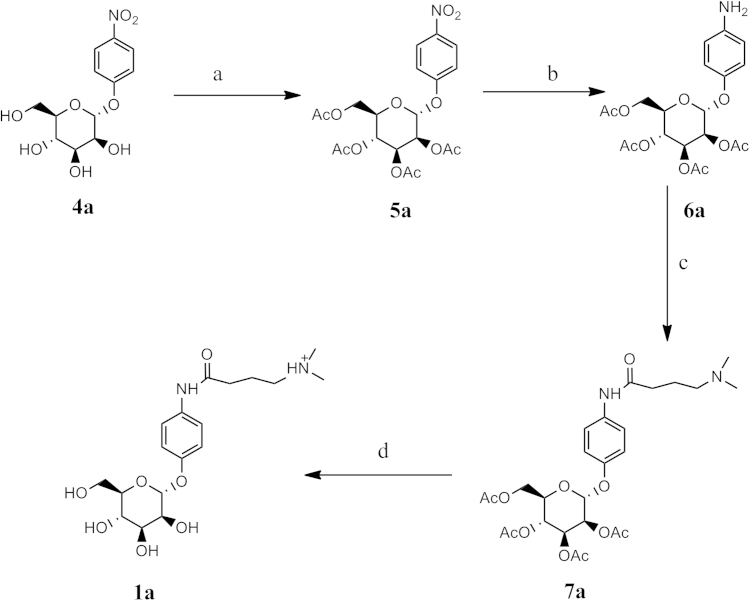
Reagents: (a) Ac2O, Pyridine, rt (b) Amm. Formate, Pd-C, MeOH, EtOAc (c) (CH3)2N(CH2)3CO2H, DCC, DMAP, CH2Cl2 (d) NaOMe/MeOH.